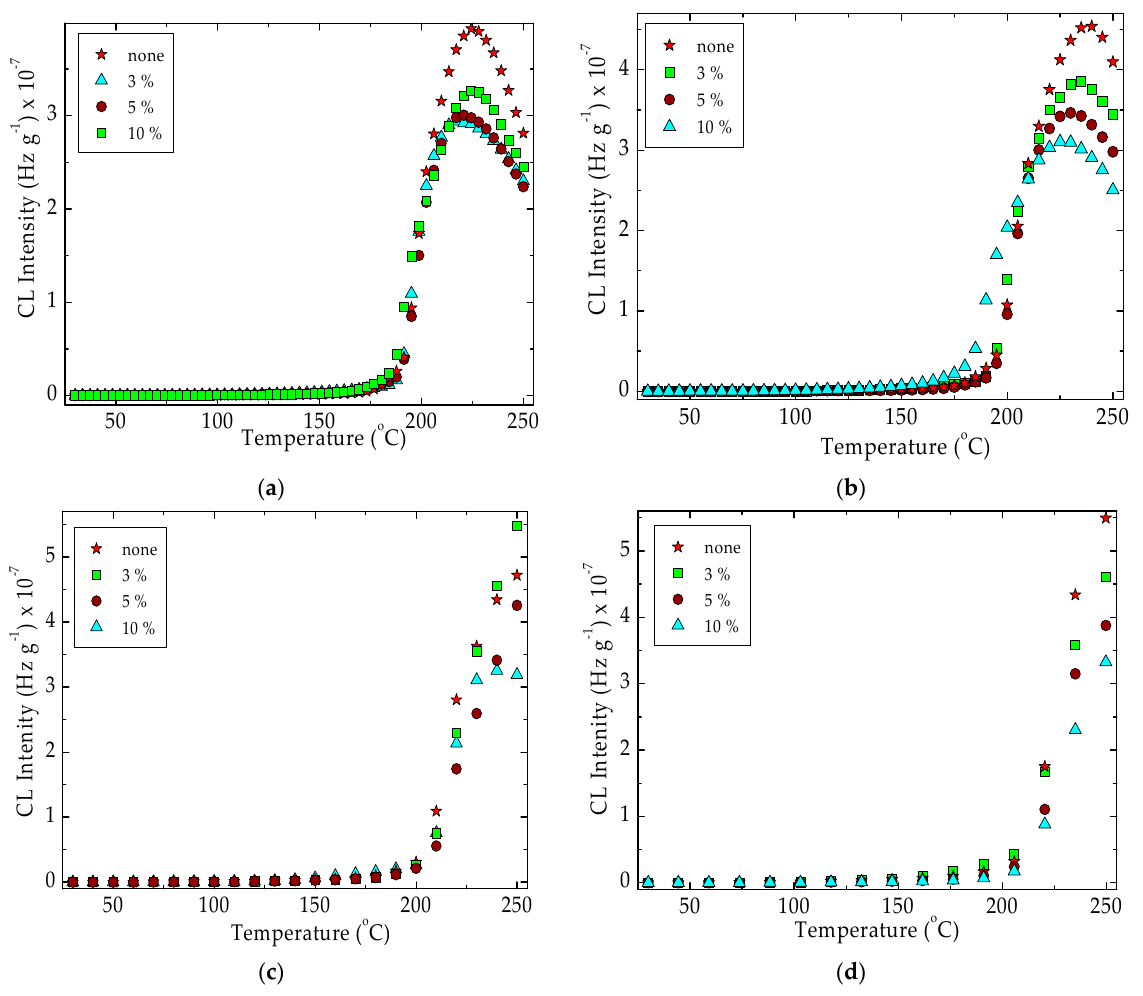
Figure 5. Nonisothermal CL spectra drawn for unirradiated PLA/SIS 30 in the presence of silica. Table 1. OOT values for the oxidation of PLA/SIS blends reinforced with SiO 2 nanoparticles obtained by nonisothermal chemiluminescence.